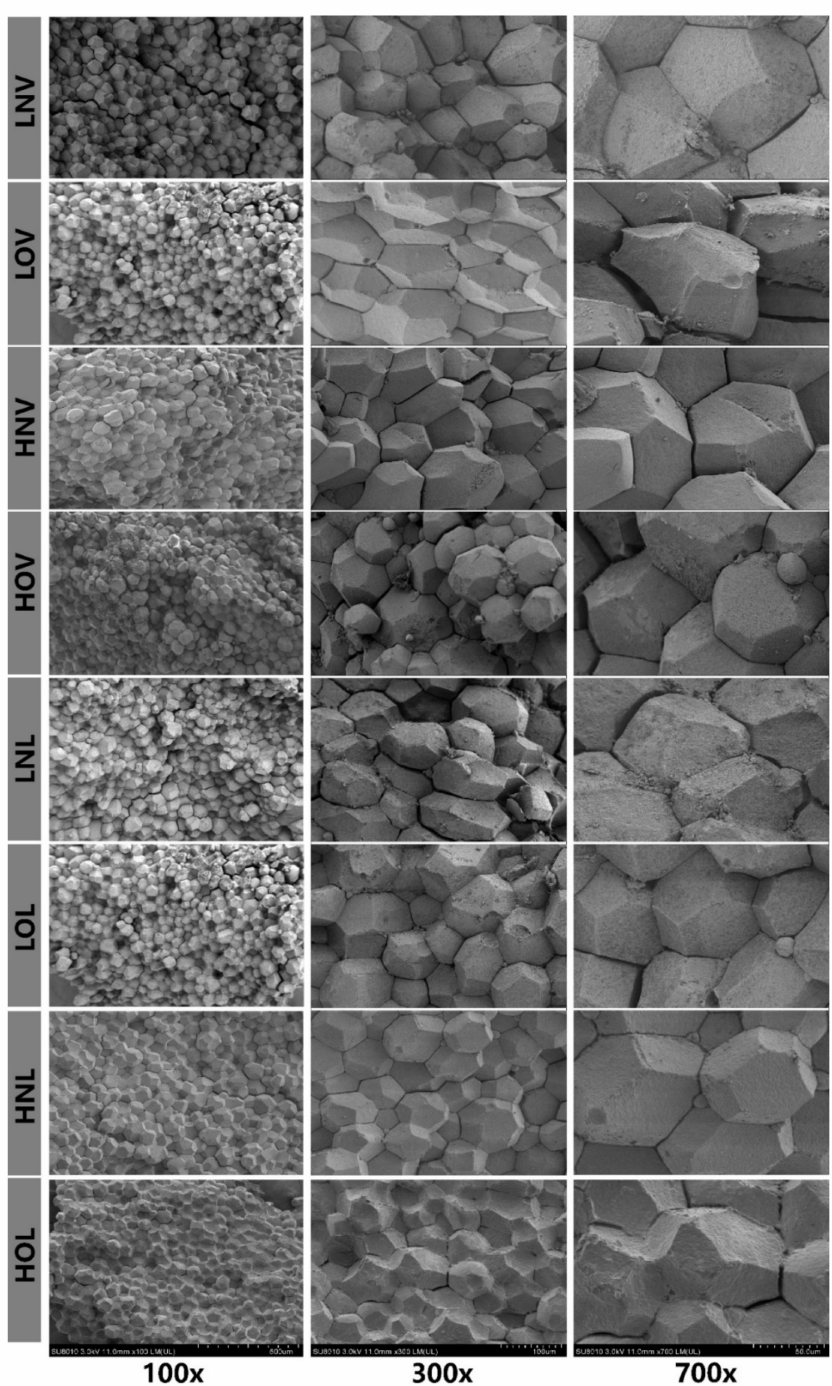
Figure 1. Micrographs of cooked yolk observed by SEM-SU8010 at different magnifications. The ab- scissa indicates the different magnifications. LNV = low-dose normal vegetable oil, HNV = high-dose normal vegetable oil, LNL = low-dose normal lard, HNL = high-dose normal lard, LOV = low-dose oxidized vegetable oil, HOV = high-dose oxidized vegetable oil, LOL = low-dose oxidized lard, HOL = high-dose oxidized